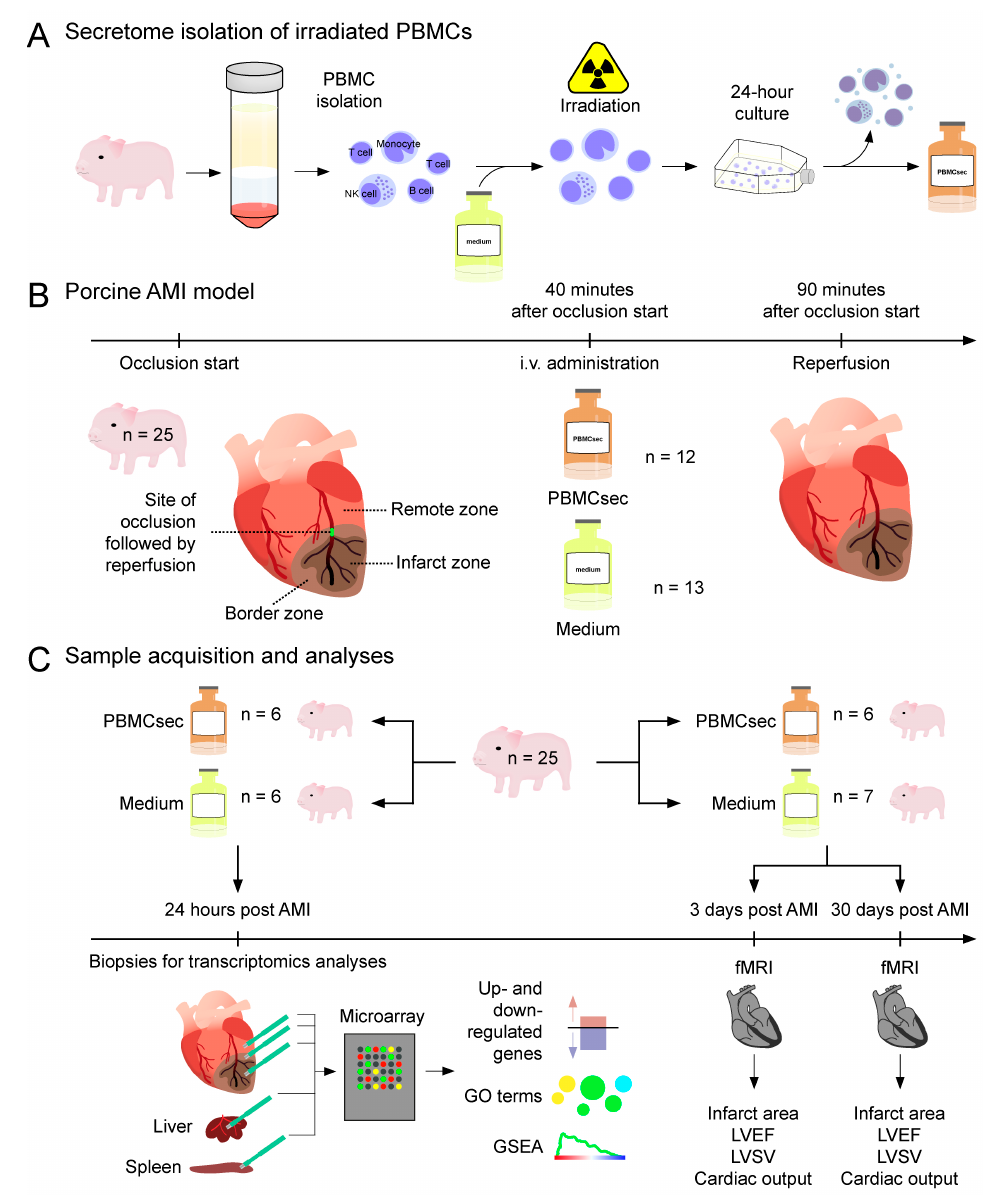
Figure 1. Background and experimental approach. ( A ) Porcine PBMCs were enriched, irradiated, and cultured for 24 h. Cells and cellular debris were removed and the supernatant containing the secretome was lyophilized. ( B ) Reperfused AMI was induced via balloon occlusion of the left anterior descending coronary artery (LAD) for a total duration of 90 min, followed by reperfusion. Forty minutes after starting the balloon inflation, the PBMCsec (n = 12 animals) or medium used for the PBMC culture (n = 13) were injected over 25 min. ( C ) For the in silico analyses, biopsies of infarcted, transition, and non-infarcted myocardium, as well as liver and spleen of the PBMCsec-treated (n = 6) and medium-treated pigs (n = 6), were obtained 24 h post AMI. Transcriptional analyses included the identification of up- and downregulated genes, Gene Ontology (GO) term analysis, and gene set enrichment analysis (GSEA). Cardiac performance was determined using functional magnetic resonance imaging (fMRI) 3 days and 30 days after the AMI and assessed in terms of infarct area, LVEF, LVSV, and cardiac output. fMRIs of the PBMCsec-treated (n = 6) and medium-treated (n = 7) pigs was performed 3 days and 30 days after the AMI. AMI: acute myocardial infarction, GO: gene ontology, GSEA: gene set enrichment analysis, i.v.: intravenous, fMRI: functional magnetic resonance imaging, LVEF: left ventricular ejection fraction, LVSV: left ventricular stroke volume, PBMCsec: secretome of stressed porcine peripheral blood mononuclear